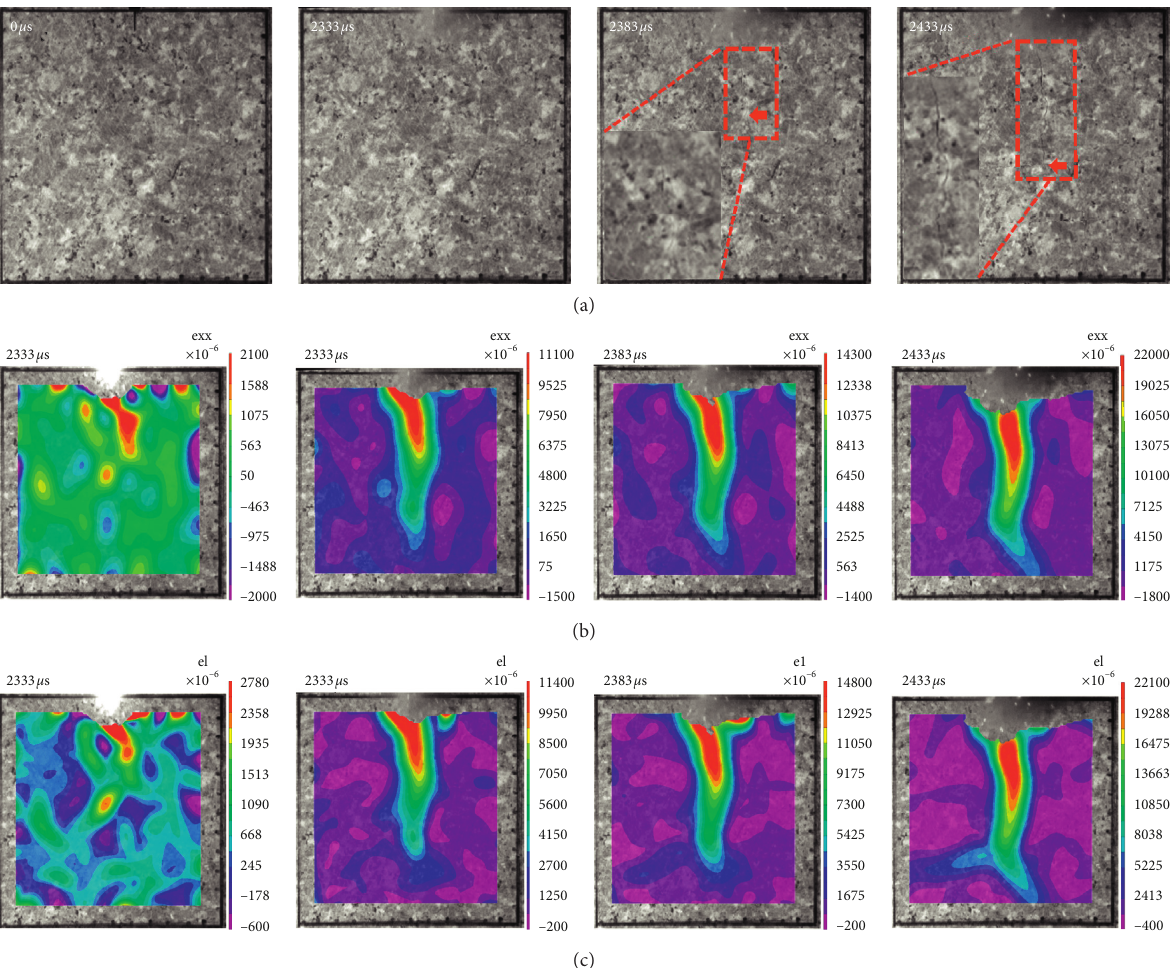
Figure 6: Crack evolution and full-field strain at different stages for test 1. (a) Crack evolution, (b) axial strain, and (c) principal